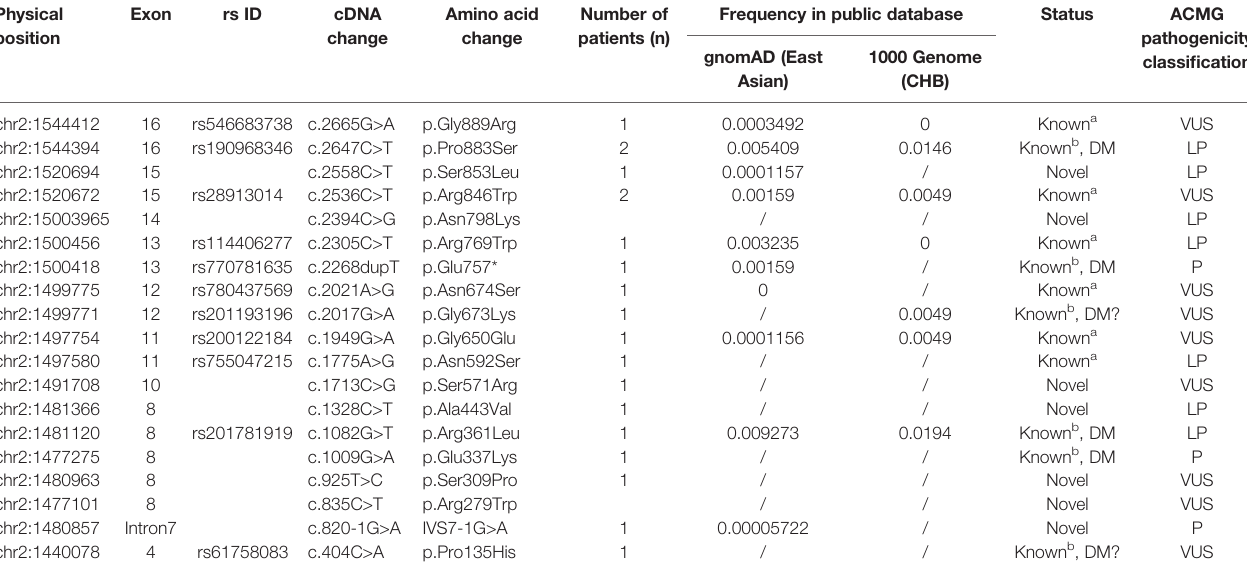
TABLE 2 | Detailed information of detected TPO variants.